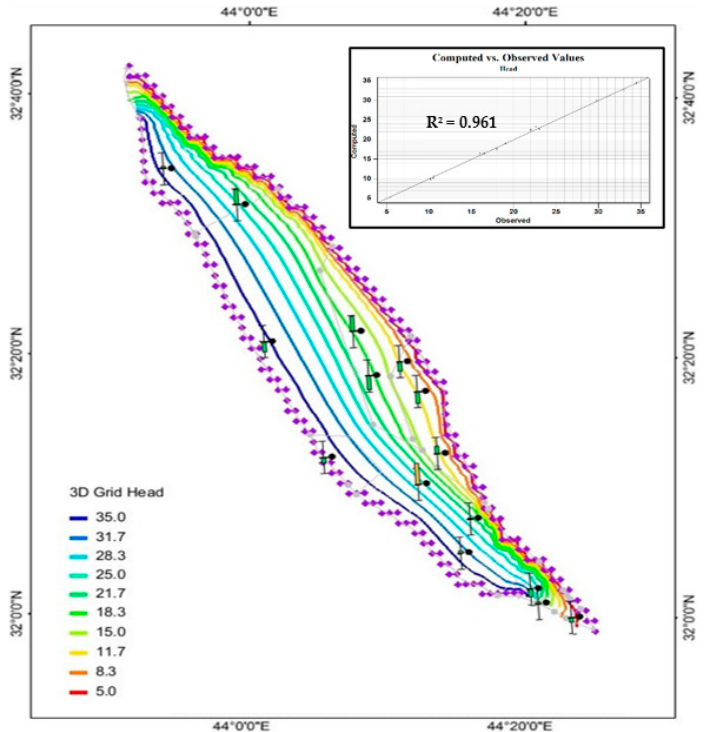
Figure 3. Simulated heads after calibration of the study aquifer under steady state.